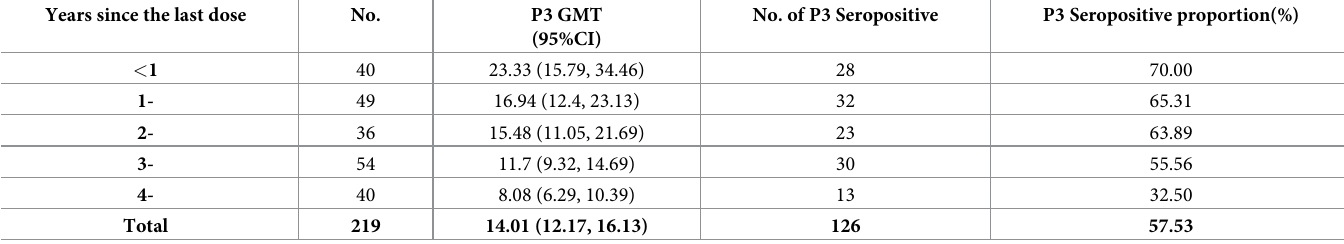
Table 3. Japanese encephalitis neutralizing antibody and seropositive proportion against P3 strain for participants with two doses of JEV-L in Zhejiang, 2015– 2016. Years since the last